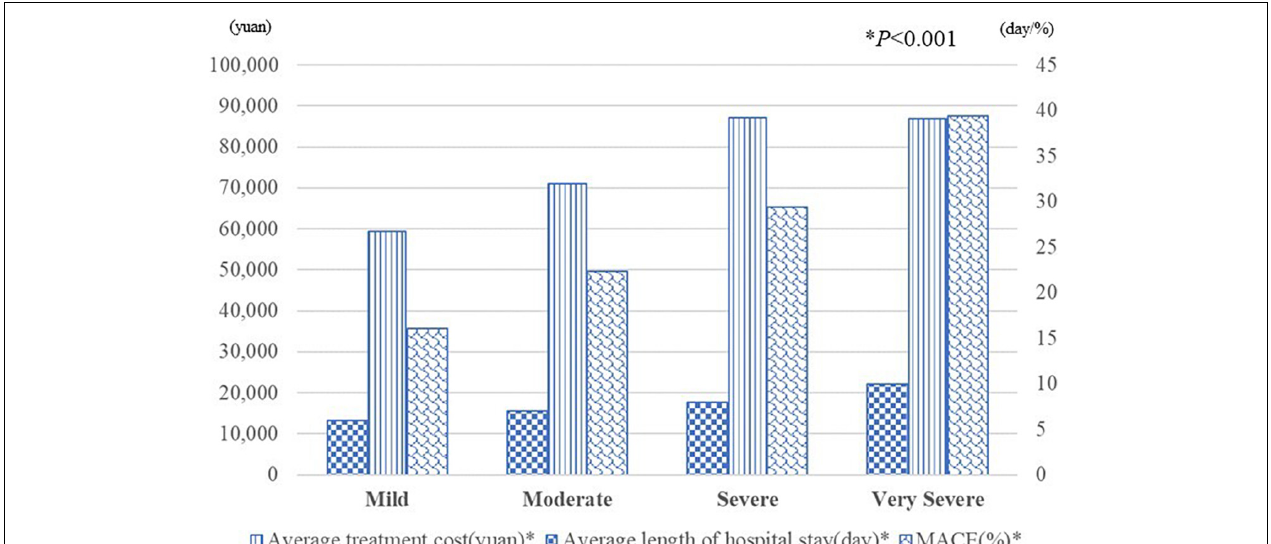
FIGURE 5 | The average treatment cost, length of hospital stay and the incidence of MACE in each severity stratification. * P <